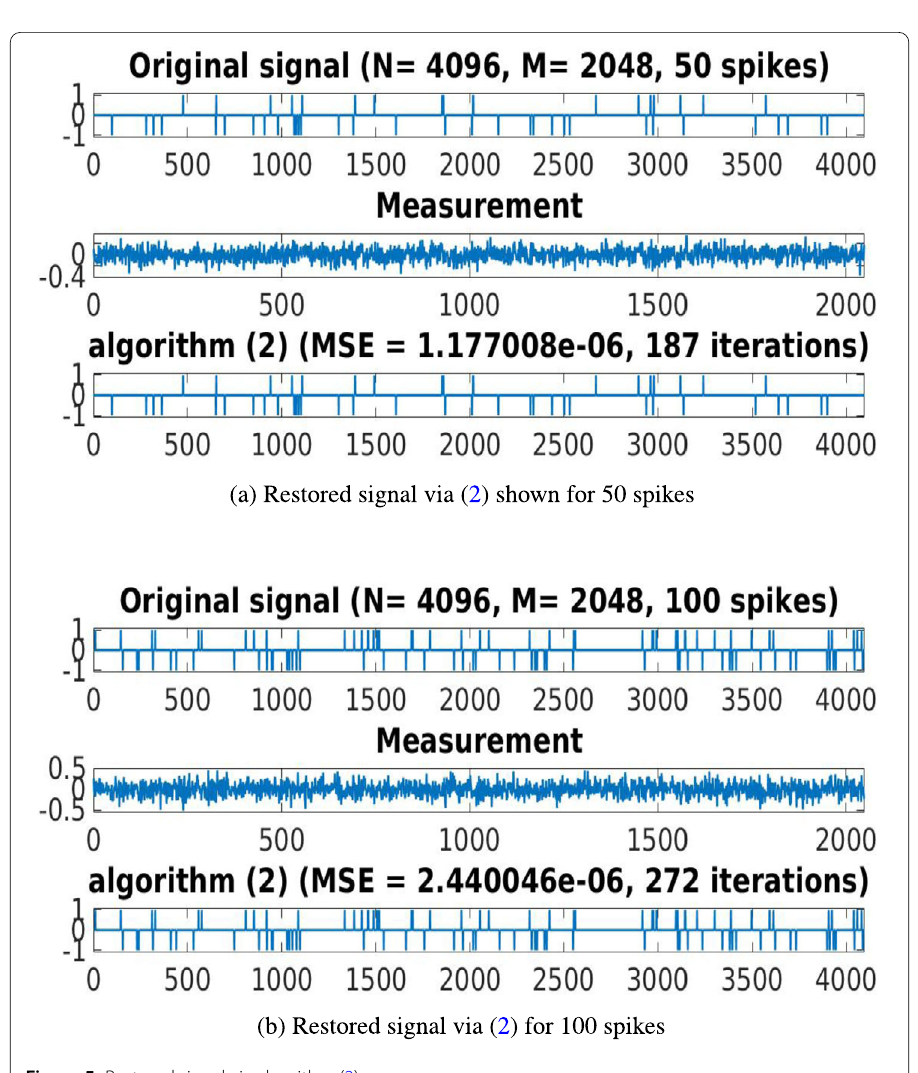
Figure 5 Restored signal via algorithm